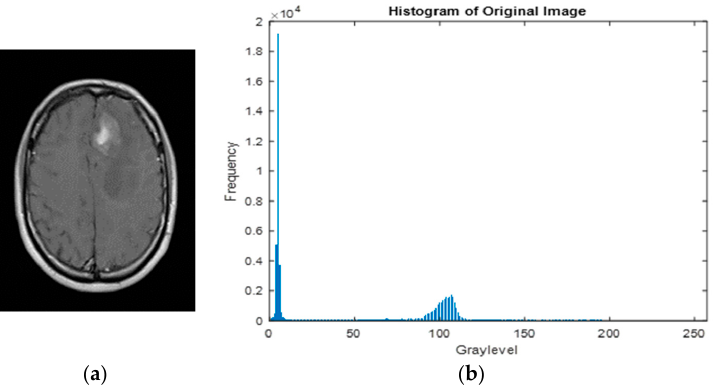
Figure 4. ( a ) Original Image; ( b ) Histogram Image.